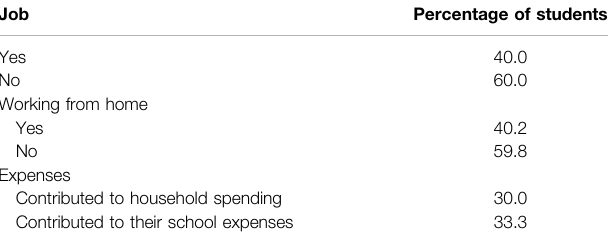
TABLE 2 | Job pro fi le of